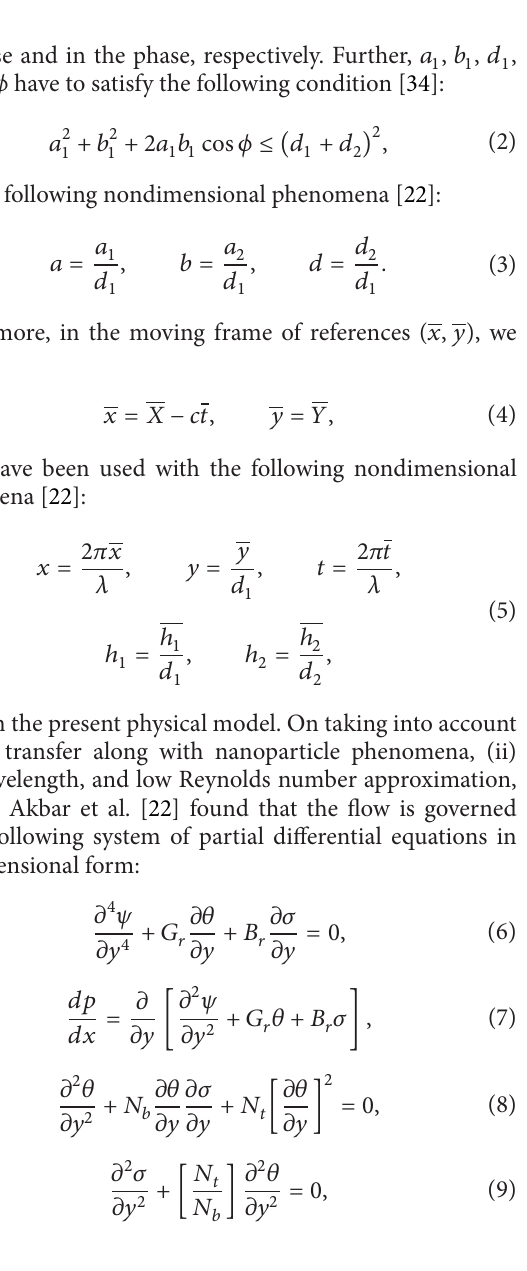
Figure 1: Schematic diagram of a two-dimensional asymmetric